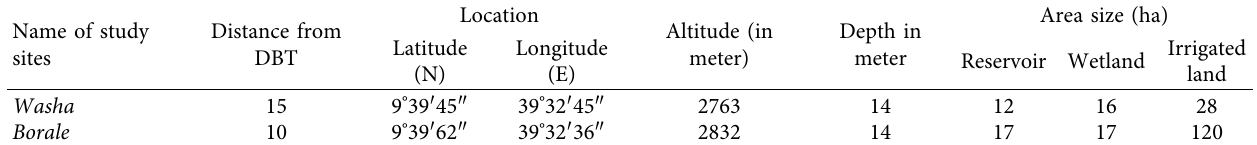
Figure 1: A map of the study area with its land use land cover (LULC) in the North Shewa zone (with its districts) of the Amhara region, Table 1: The name, location, and land size of the study area, including irrigated land.